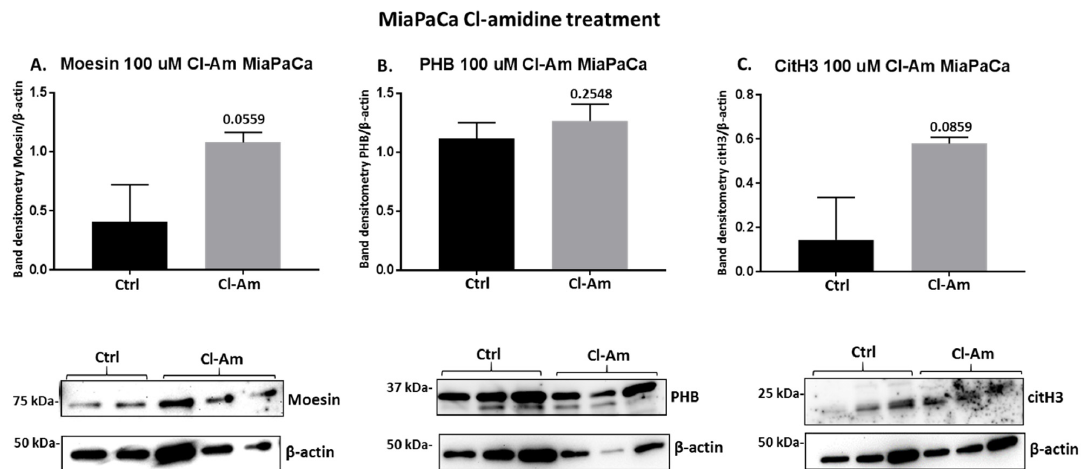
values are shown (significance at p ≤ 0.05 was not reached), error bars show SD ( n = 3 biological replicates for all, repre- sentative Western blots are shown beneath the respective histograms).